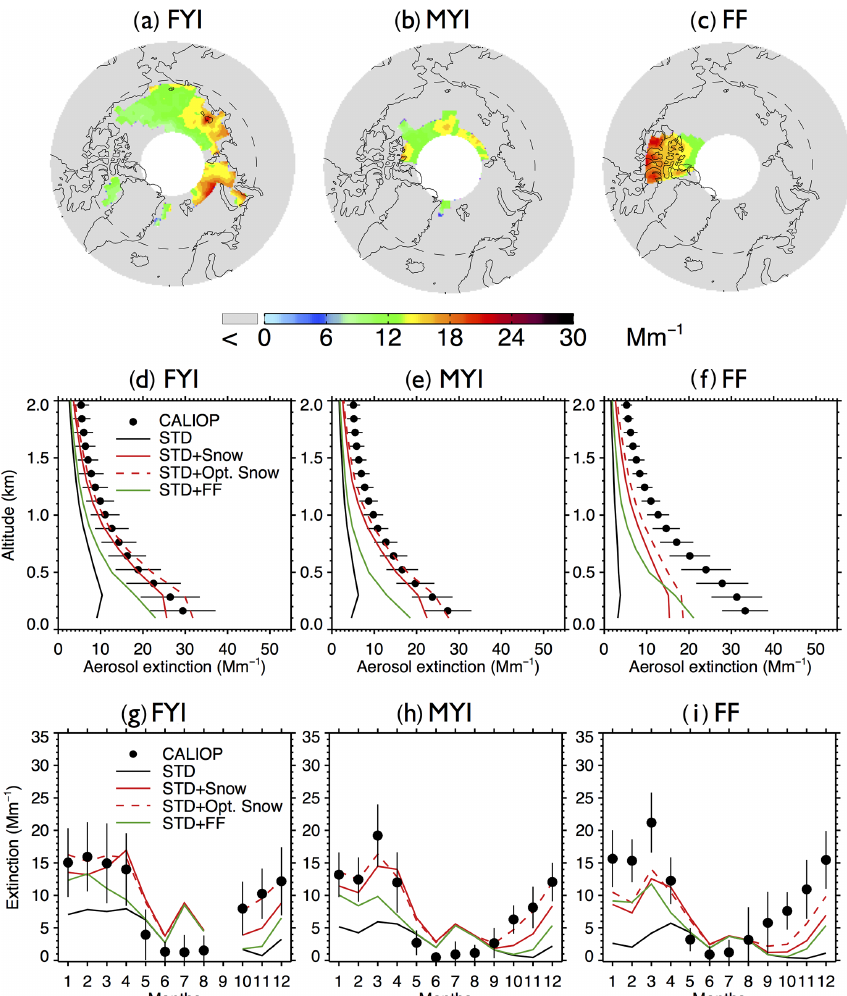
Figure 3. (a–c) 2007–2009 CALIOP mean aerosol extinction coefficients (0–2km) in the Arctic cold season (November–April) over (a) first- year sea ice (FYI), (b) multi-year sea ice (MYI), and (c) the Canadian Arctic Archipelago (CAA). (d–f) vertical profiles of Arctic cold- season mean aerosol extinction coefficients over (d) FYI, (e) MYI, and (f) CAA for CALIOP (black dots with horizontal lines indicating standard deviations) and GEOS-Chem model simulations (STD: black lines, STD + Snow: red solid lines, STD + Opt. Snow: red dashed lines, STD + FF: green lines). (g–i) seasonal cycle of 0–2km monthly aerosol extinction coefficients averaged over (g) FYI, (h) MYI, and (f) CAA. CALIOP observations are shown as black circles, and vertical lines indicate the interannual standard deviation. The four GEOS-Chem model simulations are also shown (STD: black lines, STD + Snow: red solid lines, STD + Opt. Snow: red dashed lines, STD + FF: green